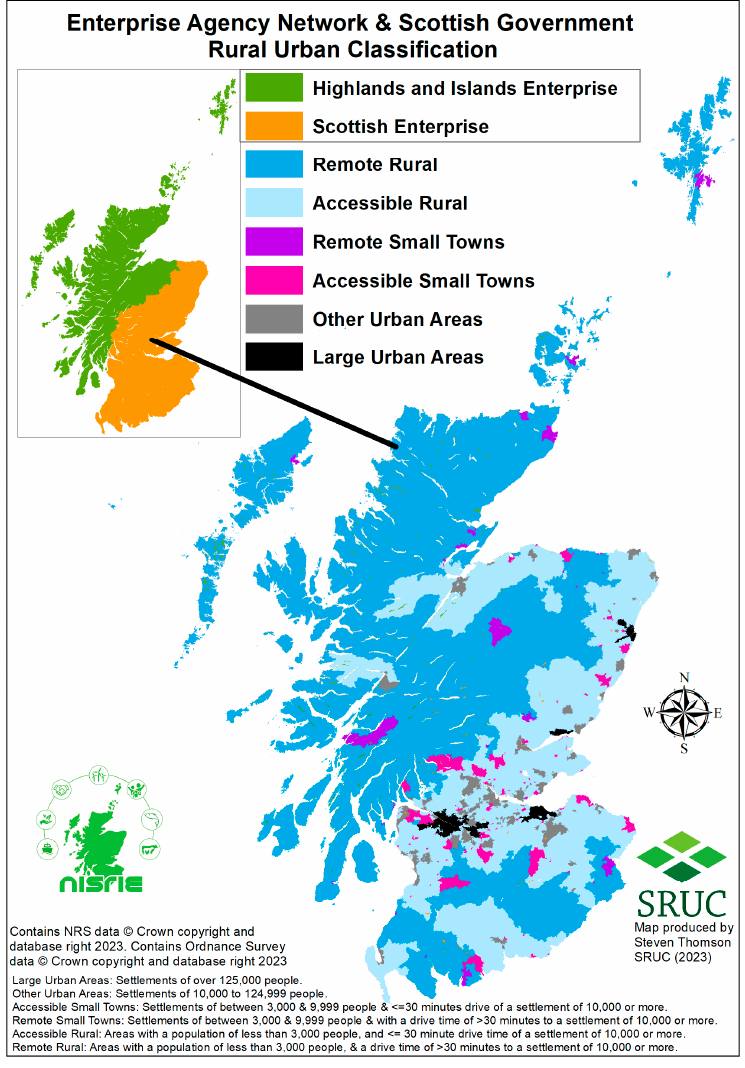
Figure 1. Sco tt ish landscape map. Source: map produced by Steven Thomson Figure 1. Scottish landscape map. Source: map produced by Steven